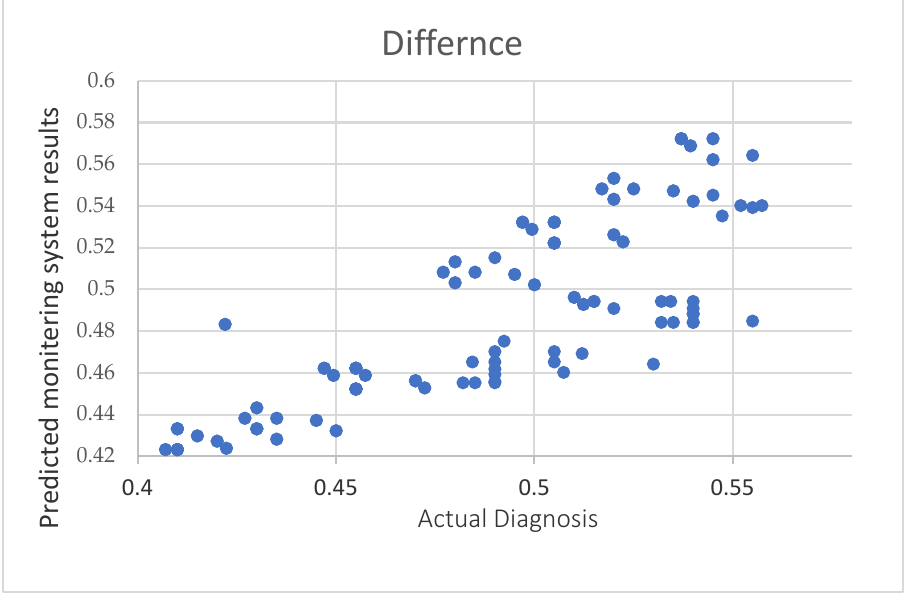
Figure 7. The correlation of the real ratio of health risk incidence in cases from a medical diagnosis versus the prediction of risk incidence from the proposed monitoring system.